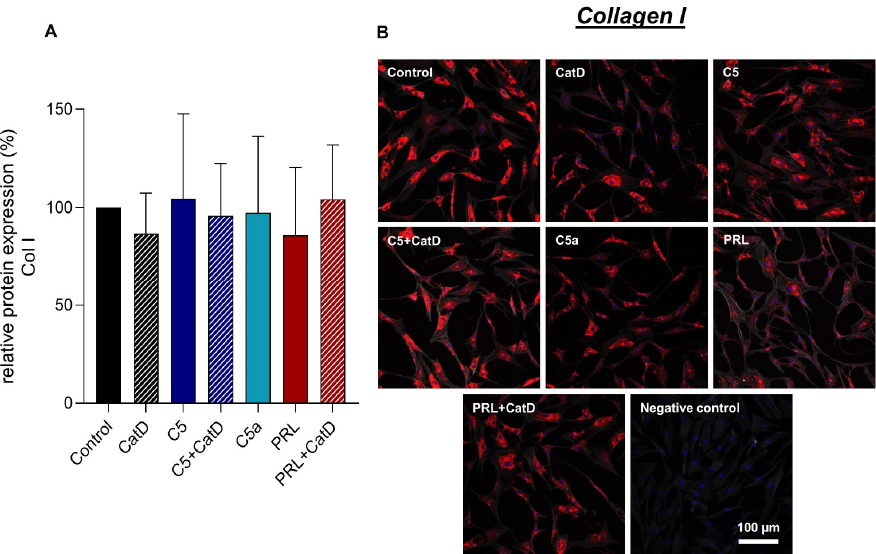
Figure 4. Chondrocytes protein expression of collagen type I after 72 h of stimulation and negative control of the staining. n = 4 independent experiments with chondrocytes from different donors. ( A ): Graphic representation of relative collagen type I protein fluorescence intensity, mean with standard deviation. Control has been normalized to 1. One sample t -test with significance in relation to control. Mixed-effects analysis using post-hoc Tukey’s multiple comparisons. ( B ): representative images of chondrocytes immunolabeled with collagen type I specific antibodies. Red (Cy3) = collagen type I, blue (DAPI) = cell nuclei, grey (Phalloidin Alexa 633) = actin cytoskeleton. Scale bar = 100 µ m.